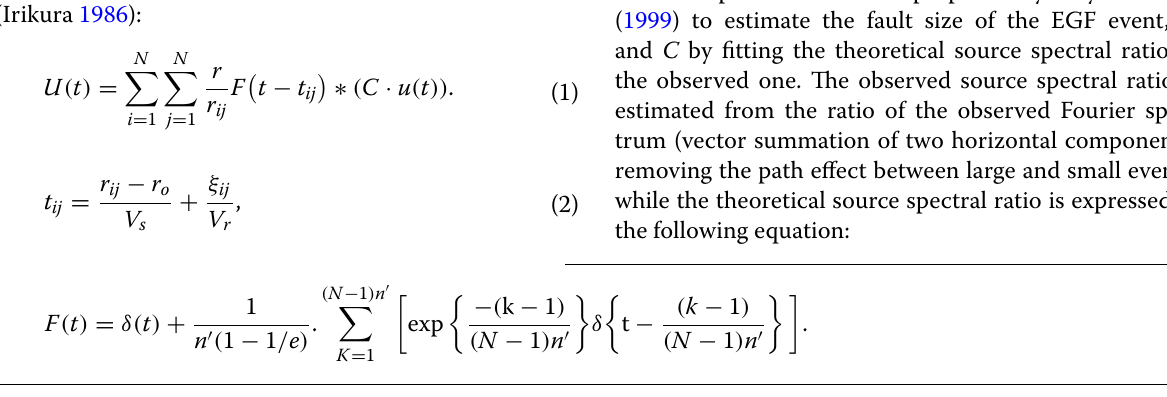
Where U ( t ) represents the ground motions of a large event, and u ( t ) is the ground motions of a small event regarded as the empirical Green’s functions (EGFs). The subscripts i and j are indices increasing along the strike and dip directions, respectively. The terms r , r ij , and r 0 are the respective distances from the station to the hypo- center of the small event, from the station to the ( i,j ) sub- fault, and from the station to the rupture starting point on the fault plane of the large event. In addition, ξ ij is the distance between the rupture starting point and the ( i,j ) subfault. V s and V r are the S-wave velocities in the source region and rupture velocity on the fault plane, respectively. F ( t ) is the correction function of slip veloc- ity between large and small events which was modified by Irikura et al. (1997). The parameters, N and C , are the ratios of fault sizes (length and width) and stress drops between the large and small events, respectively. Fur- thermore, n ’ is the division number to shift the artificial periodicity to a frequency higher than that of interests, e Euler’s number, and Γ the rise time of the large